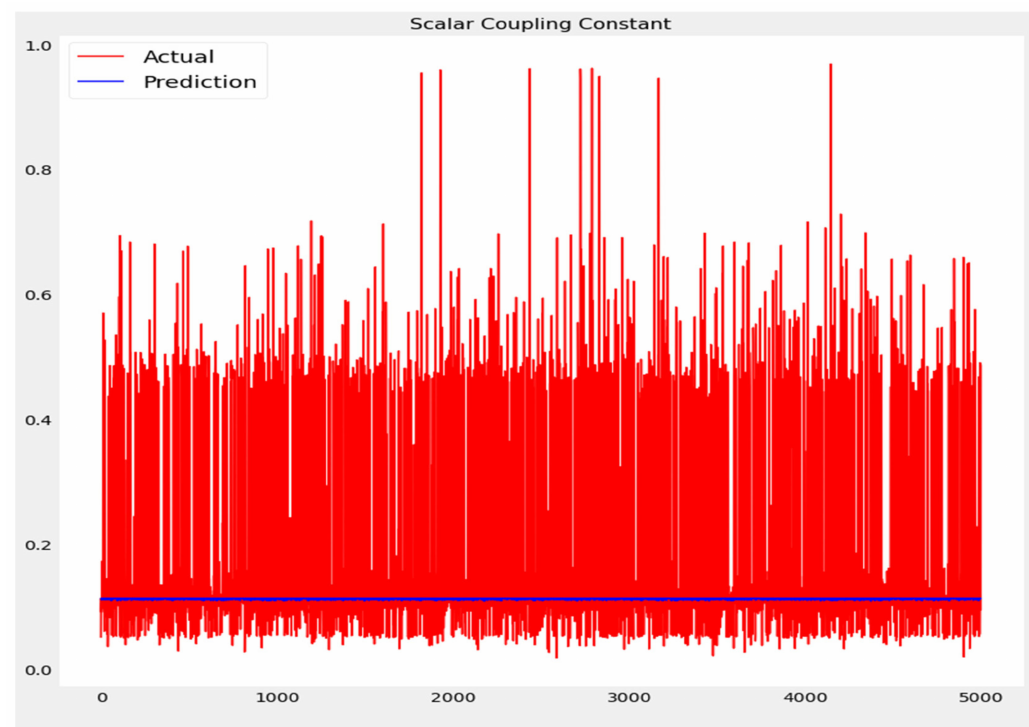
Figure 12. Actual and prediction values of RNN.